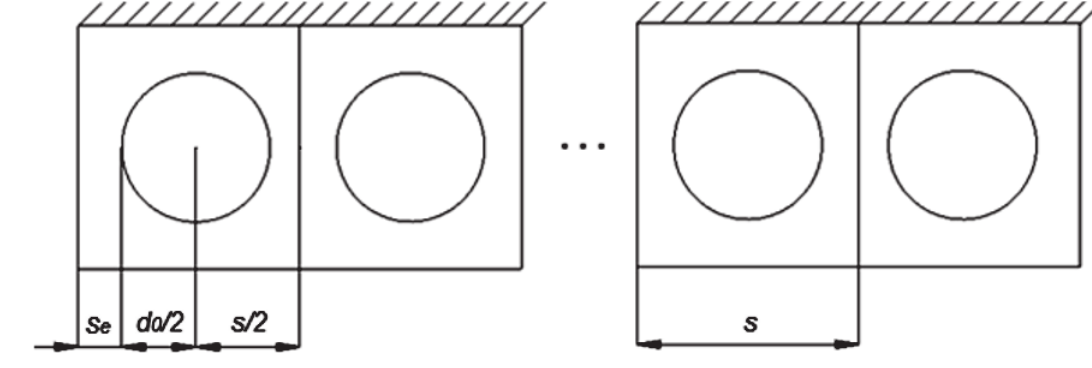
Figura 10 Modelo para viga celular com n aberturas